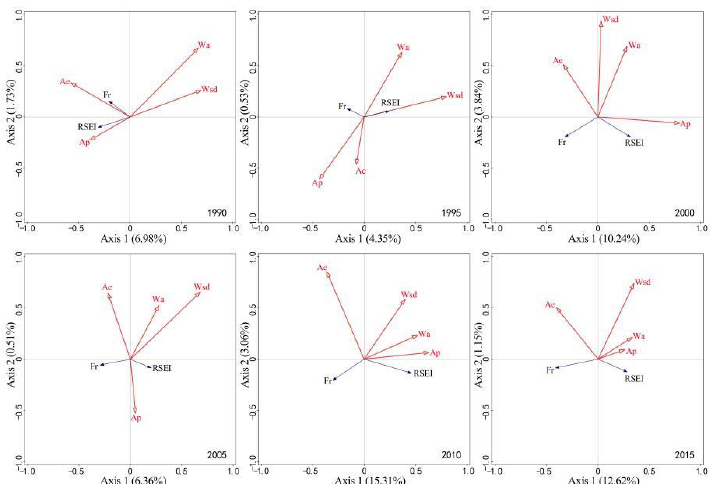
Figure 9. Correlation of RSEI and Fr with water factors. Note: RSEI, Fr, Ae, Ap, Wa, and Wsd re- spectively represent remote sensing-based ecological index, rock outcrop rate, annual actual evap- otranspiration, annual precipitation, water body area, and water surface density; RSEI and Fr are response variables and the rest are interpretation variables.